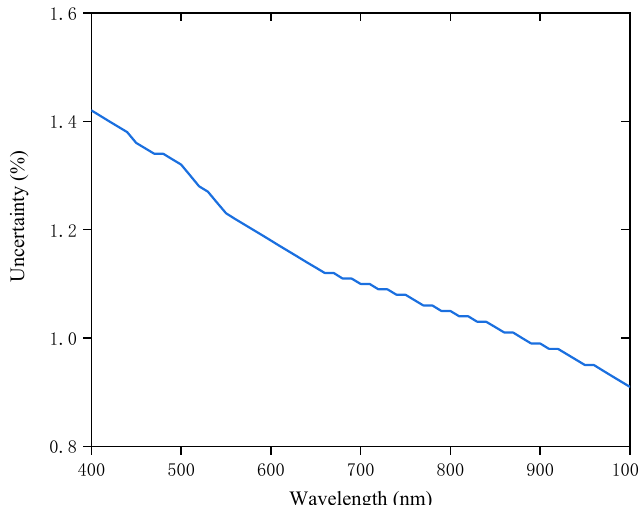
Figure 11. The uncertainty of the surface spatial heterogeneity covering 400 nm to 1000 nm for the desert target.